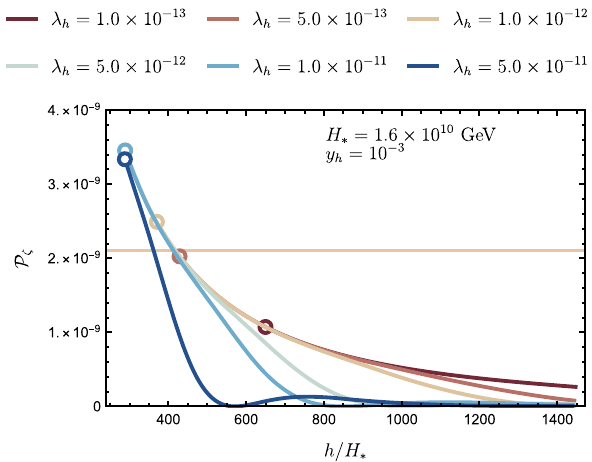
Fig. 1 Theamplitudeofthepowerspectrumsourcedbythemodulation mechanism computed at the pivot scale k ∗ = 0 . 05 Mpc − 1 . Here H ∗ denotes the Hubble rate at the horizon exit of k ∗ . The horizontal line indicates the central value of the Planck data [32]. The circles mark the smallest field value which satisfies the mean-field condition assumed in our analysis